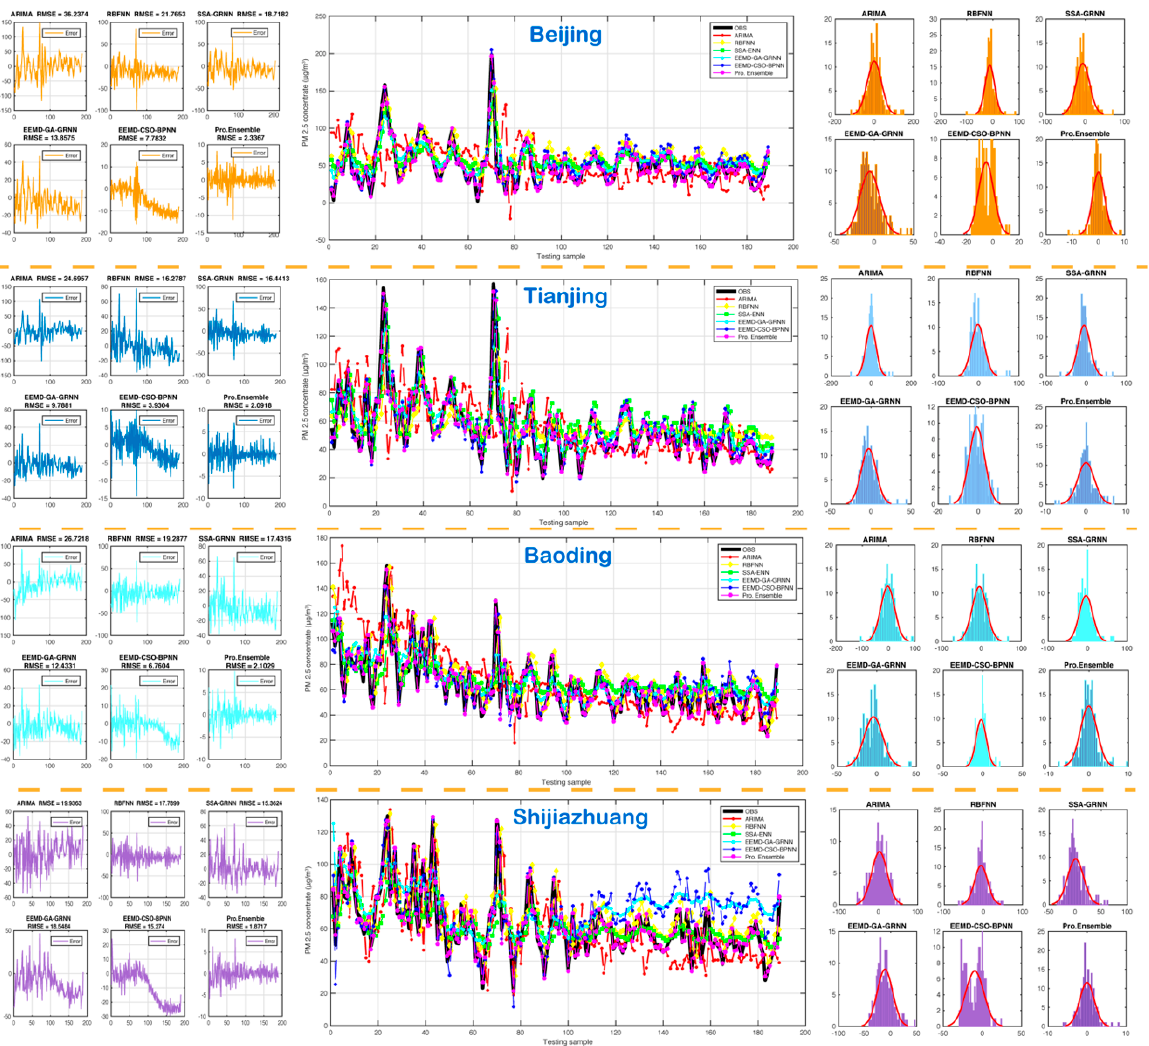
Figure 4. Forecasting results of the ensemble model and existing models.